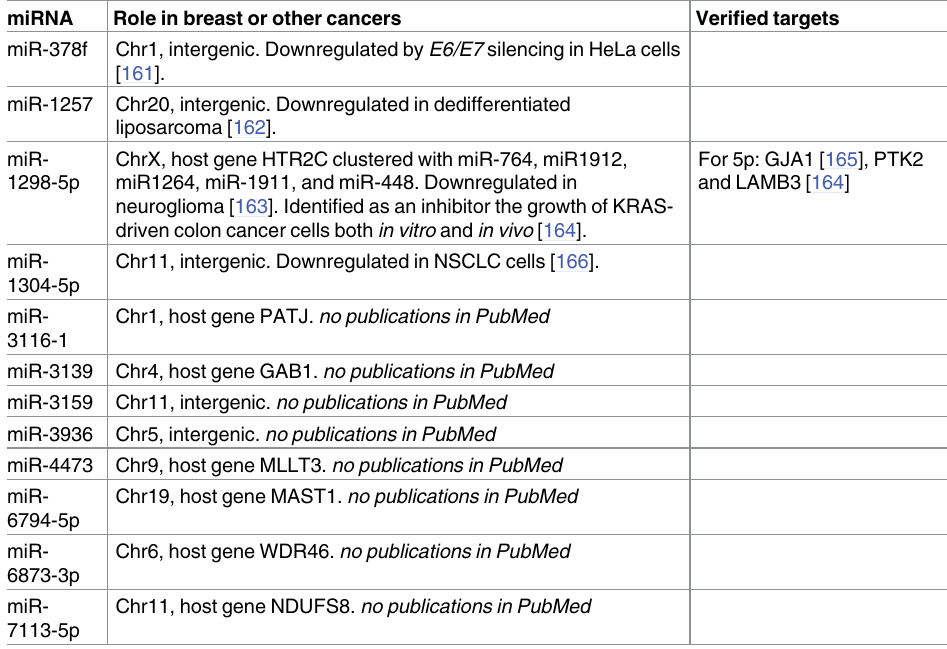
For 5p: GJA1 [165], PTK2 and LAMB3 [164]